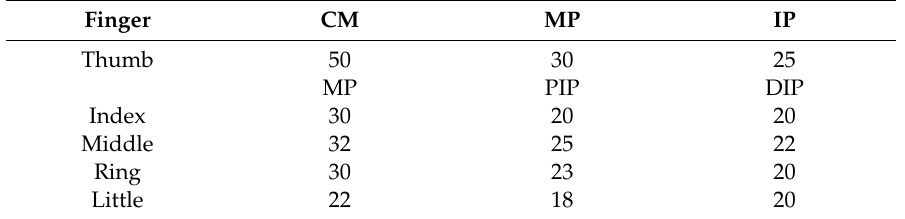
Table A4. Length of each